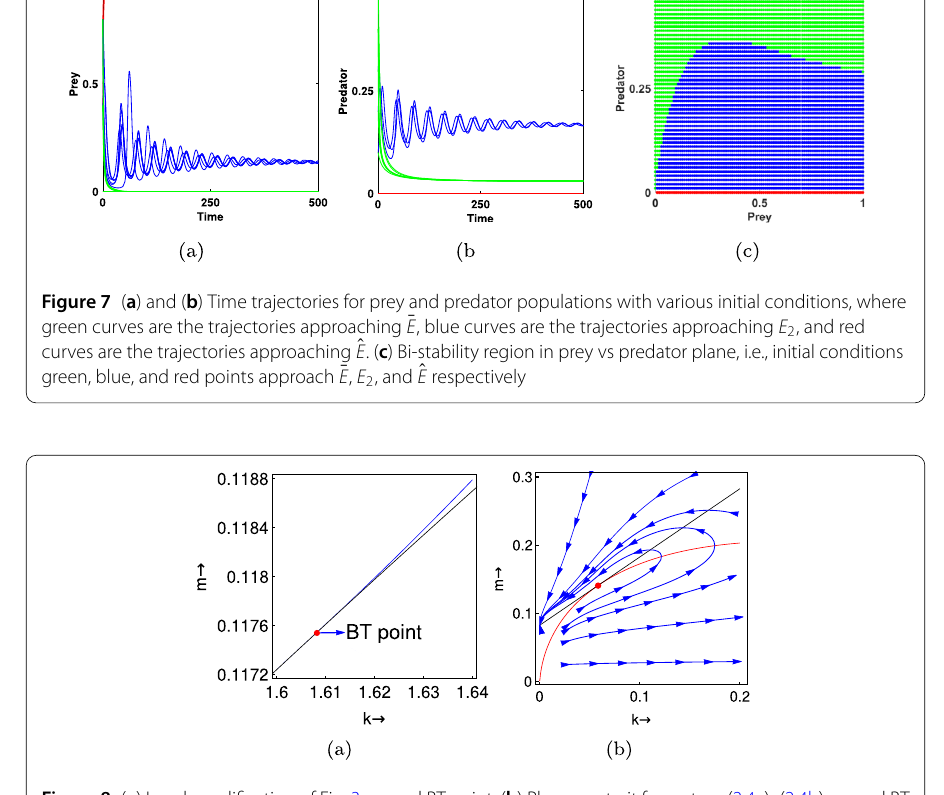
ters of system (2.4a)–(2.4b) are fixed as e = 0.05, b = 1, p = 1, h = 0.5, n = 0.2, q = 1, r 0 = 1. The scenario of no equilibrium, unique interior equilibrium, and two interior equilibria is given in Example 4.1 and showed in Fig. 1 with respect to the parameters m and k . The saddle-node bifurcation behavior for system (2.4a)–(2.4b) for parameter m is shown in Fig. 2(a) and for k in Fig. 2(b), where the blue dashed line represents the stable equilib- rium branch and the red line represents the unstable equilibrium branch. The regions for existence of interior equilibria are shown in Fig. 2(c), where Region I is the space below the black darker line, here interior equilibrium point is not possible. Region II is the space be- tween the black dashed line and the black thick line, here two interior equilibrium points arise. On and above the black dashed line representing Region III, the unique interior equi- librium point appears. In Fig. 3, the two-parameter bifurcation diagram is plotted, since the trace value is zero on the blue line, which separates the stable and unstable region, and the red dot denotes the Bogdanov–Takens bifurcation point, i.e., the intersection point of trace and determinant equals